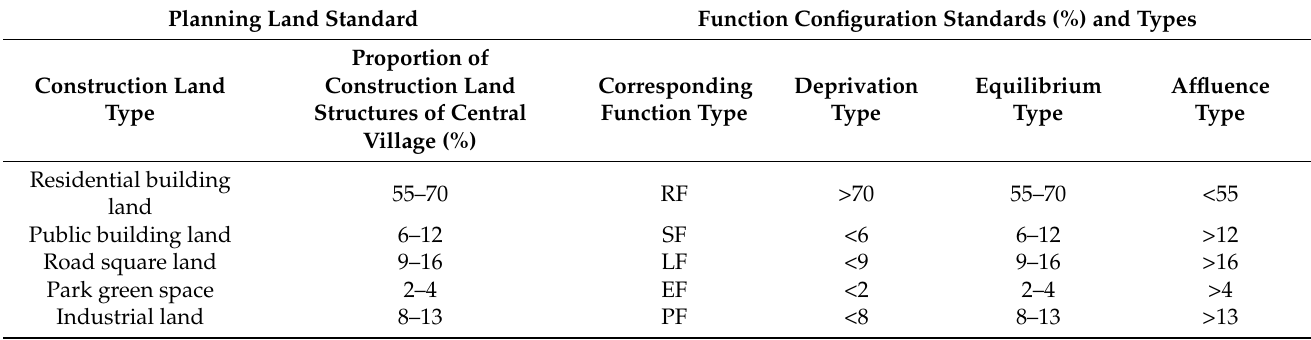
Table 2. Multifunction optimal allocation standard of rural residential land based on planning